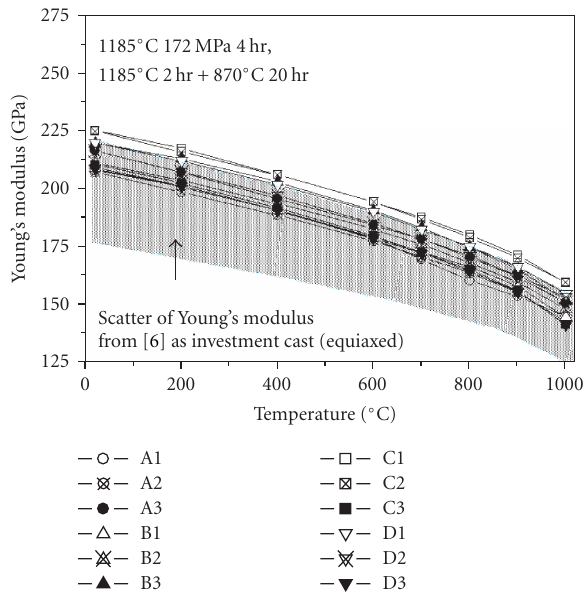
Figure 4: Young’s modulus identified from the specimens cut out from di ff erent blades in di ff erent directions.